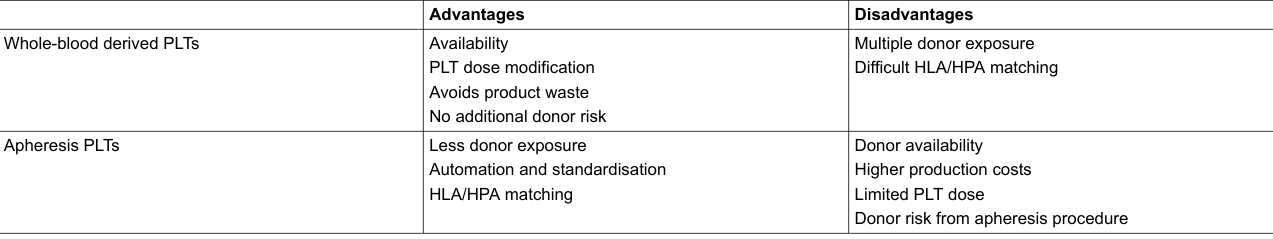
Table 1: Comparison of platelet components produced from whole blood donations or by